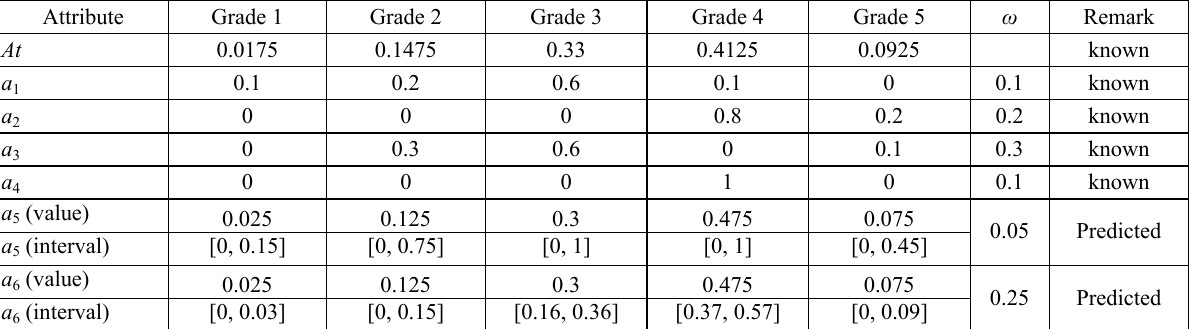
Table 4 The estimation values of missing assessments for two